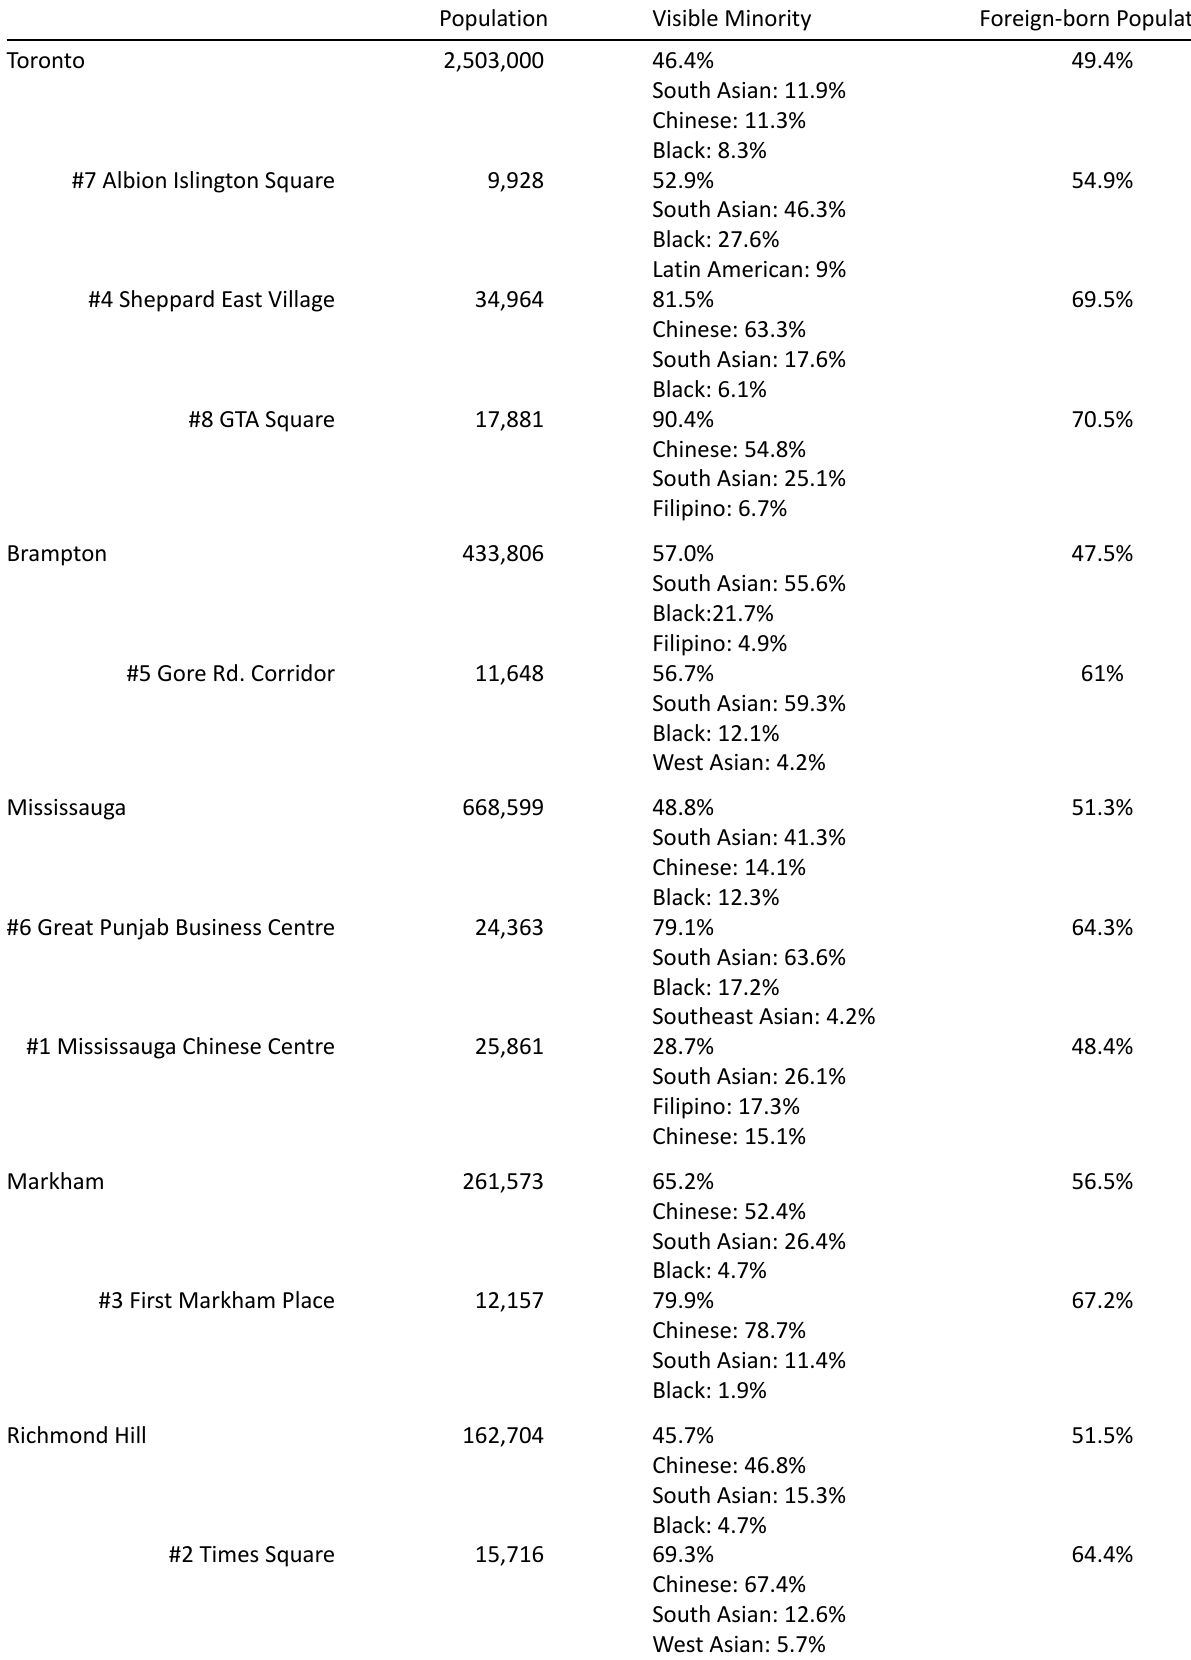
Table 1. Ethno-cultural profiles of the eight case study neighbourhoods. Population Visible Minority Foreign-born